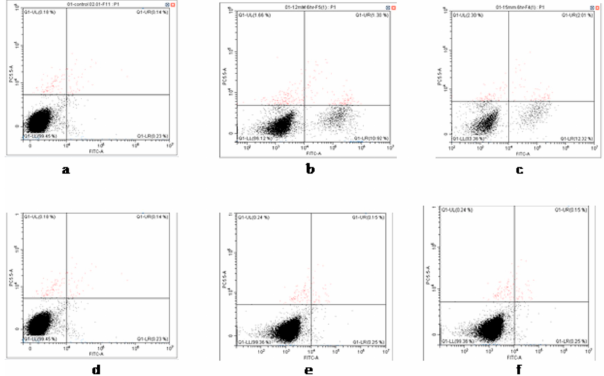
Figure 5. Examples of flow cytometry analysis of apoptosis of painted lady caterpillar cells ( a = control, b = 12 mM t-BHP and c = 15 mM t-BHP) and Turkestan cockroach cells ( d = control, e = 12 mM t-BHP and f = 15 mM t-BHP).